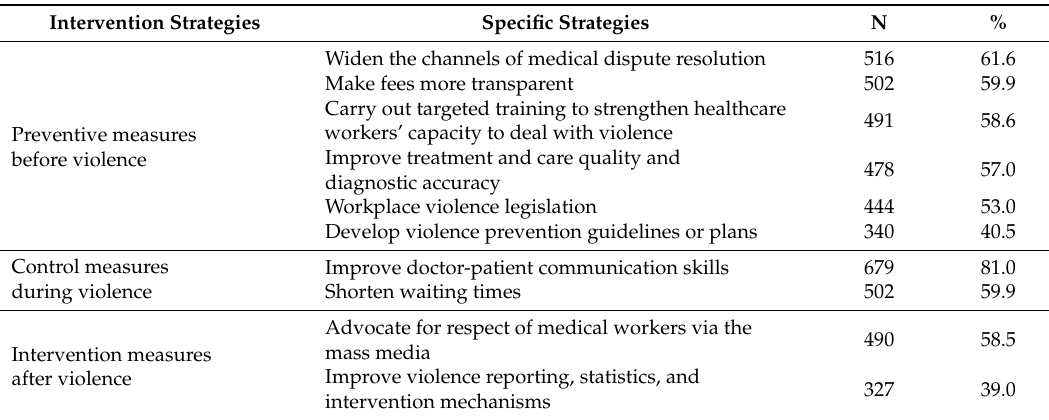
Table 4. Strategies for managing workplace violence as suggested by participants ( N =